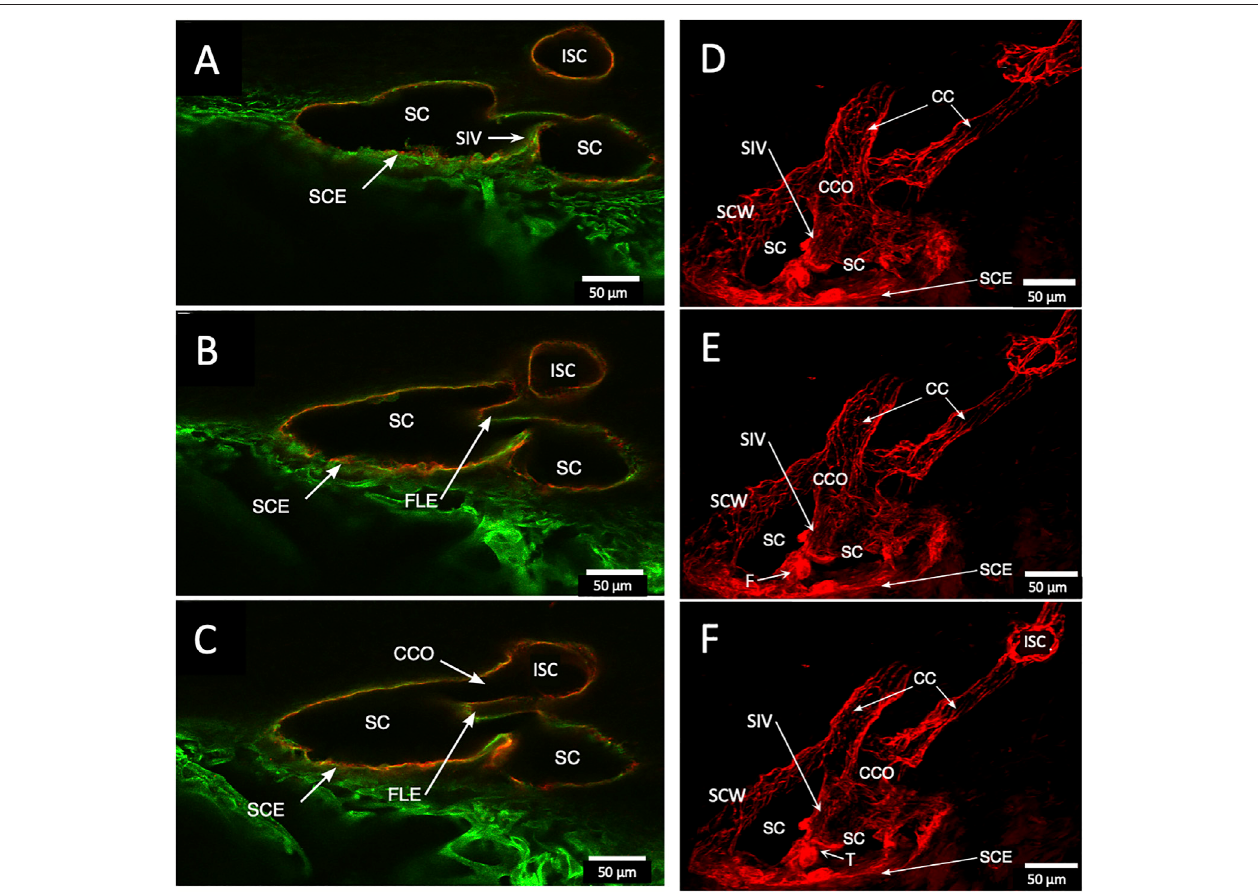
FIGURE 5 | Schlemm ’ s canal inner and outer wall connections — conduits lined by the endothelium and basement membrane labels in two different specimens. (A – C) MergedCD31(red)andColtype4(green)confocalimages.Schlemm ’ scanal(SC),SCendothelium(SCE),collectorchannels(CCs),collectorchannelostia(CCO), and relationship to fl ap-like extensions (FLE) are apparent. The funnel-shaped structure (F) develops into a cylindrical con fi guration to create a SC inner wall valve-like conduit (SIV) extending from SCE across SC to an FLE at a CCO. The FLE originates from the external wall sclera with a hinged arrangement forming one wall of a CCO. Notably, the cylindrical structure spanning SC approaches the external wall at the location where the CCO forms. (D – F) New specimen with confocal projection, followingCD31labeling,outlinesvascularconduits,includinganSIVarisingfromSCE,tojoincollectorchannelspassingtomoredistalintrascleralchannels. (F) CCexits SC and travels distally to join an intrascleral channel (ISC), which runs circumferentially. T is a localized artifactual disruption of SIV continuity. (A – C) #37LSN715; (D – F) #20RIN8.